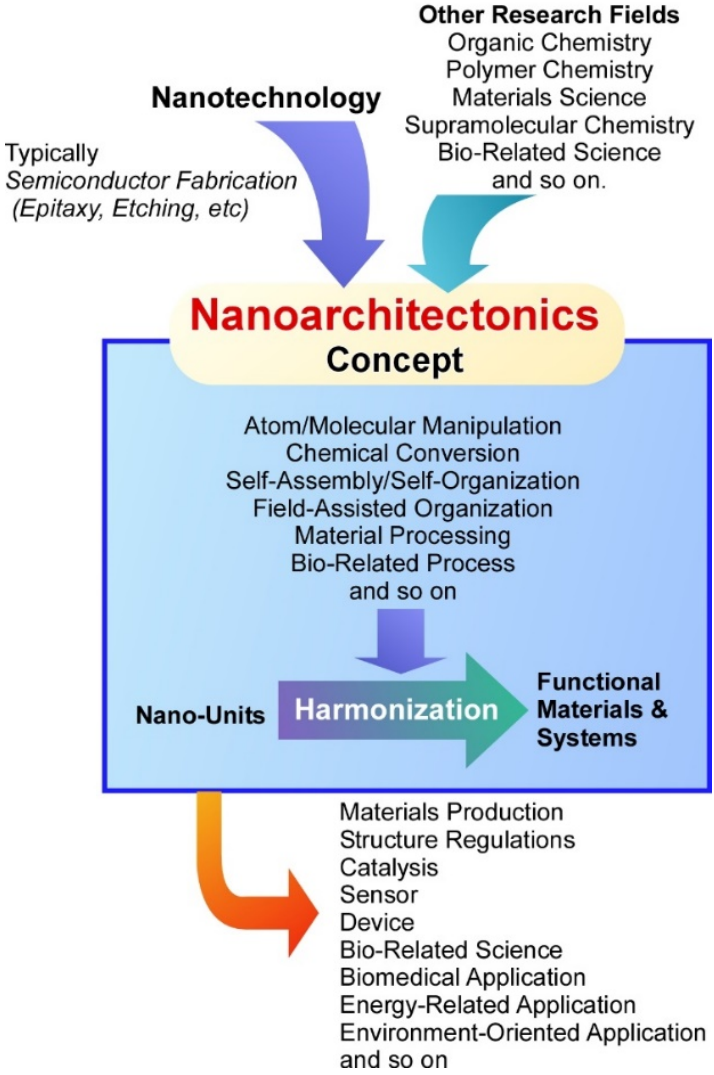
Figure 1. Outline of the nanoarchitectonics concept and contributing fields. Two-dimensional materials can be fabricated with some physical methods such as exfoliation [95,96] and chemical vapor deposition [97,98] as standard procedures. Some bottom-up-type fabrications of two-dimensional materials have been also explored as illus- trated in Figure 2. For example, syntheses of graphene-like two-dimensional nanocarbon pieces such as two-dimensional graphene nanoribbon upon well-designed organic syn- thesis have been also demonstrated (Figure 2A) [99,100]. Preparation of two-dimensional nanocarbon films from molecular carbon rings was realized using a novel technique, vor- tex Langmuir–Blodgett method, and subsequent calcination procedure (Figure 2B) [101]. Among bottom-up-type fabrications, fabrications of two-dimensional structures and assem- blies from zero-dimensional fullerenes are mainly introduced in this short review article (Figure 2C). Fullerenes are very simple objects with mono-elemental (carbon) composition and zero-dimensional structure. As demonstrated in the following sections, simple unit components of fullerenes and their derivatives can create various types of two-dimensional materials. In this review article, essences of zero-to-two nanoarchitectonics for the fabrica- tion of two-dimensional materials from zero-dimensional fullerene molecules are